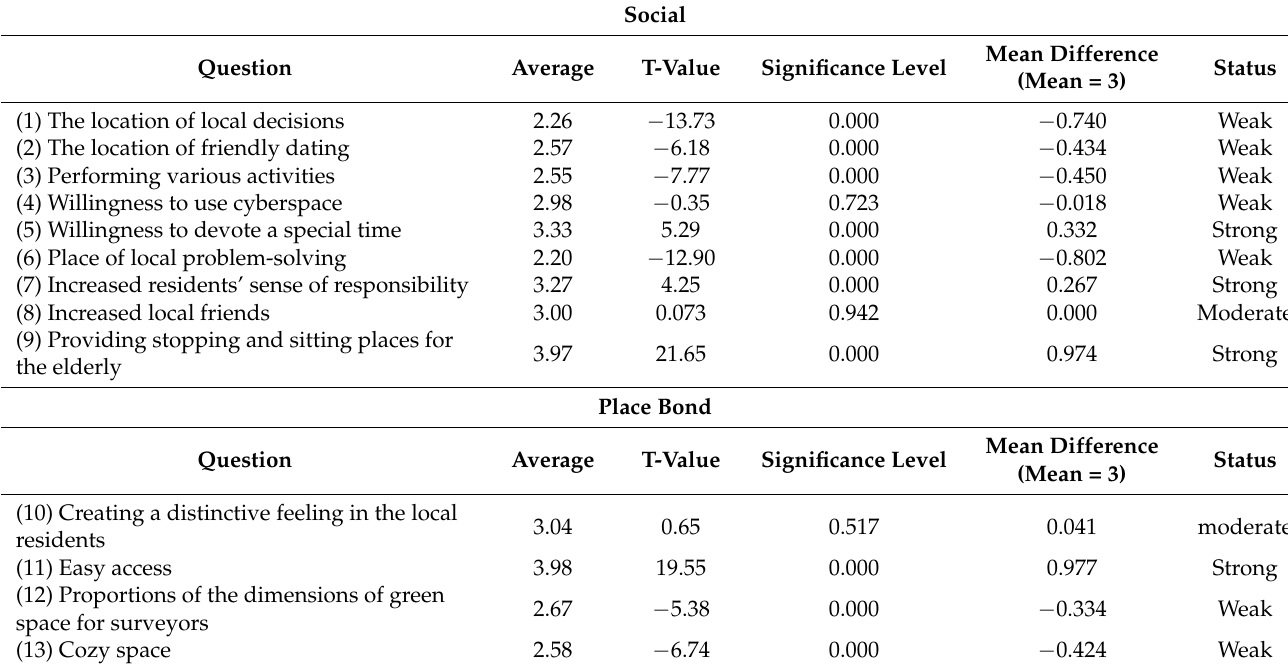
Table 2. Status of each research sub-index using a single sample t